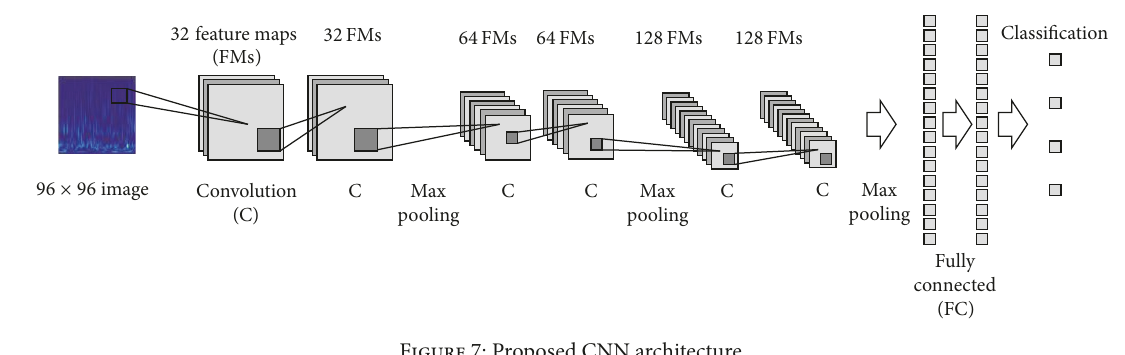
Figure 7: Proposed CNN architecture.